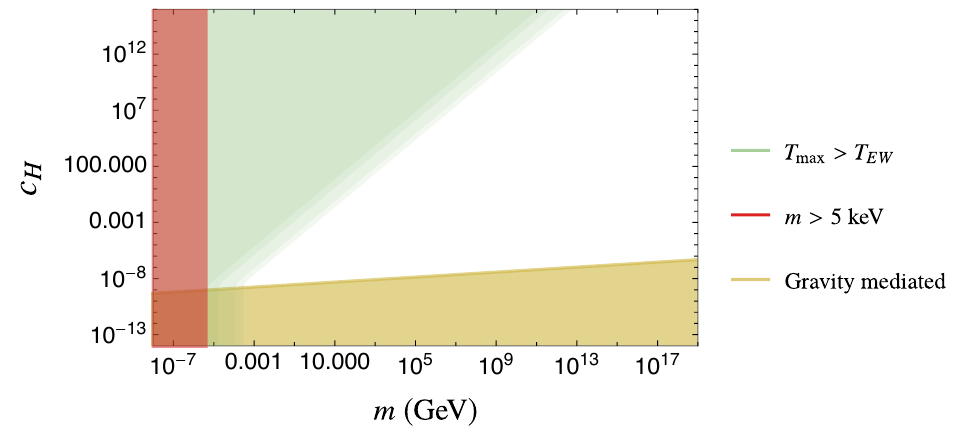
Figure 6: Spin-2 DM in the Higgs-portal scenario. We show the regions where DM production is dominated respectively by pair production with an s-channel graviton (yellow), and by single production (above the yellow region). The red region shows the small-scale structure bound m (cid:166) 5 keV, and in the green region the estimated T is below the electroweak max